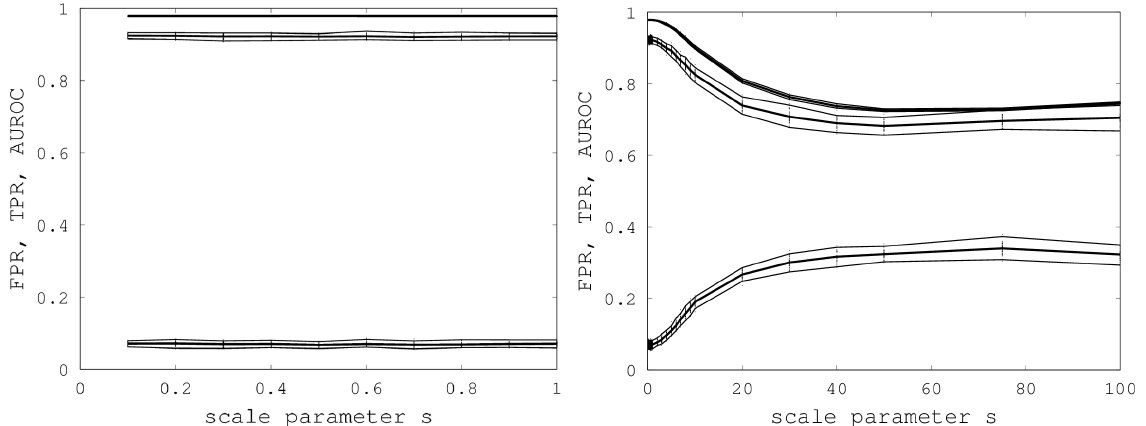
Figure 6. On the left, AUROC (top) and the best TPR (middle) and FPR (bottom) are shown as s ranges from 0 . 1 to one. On the right, AUROC (top) and the best TPR (middle) and FPR (bottom) as s ranges from 0 . 1 to 100 . 95% bootstrap confidence intervals are shown in both graphs for all